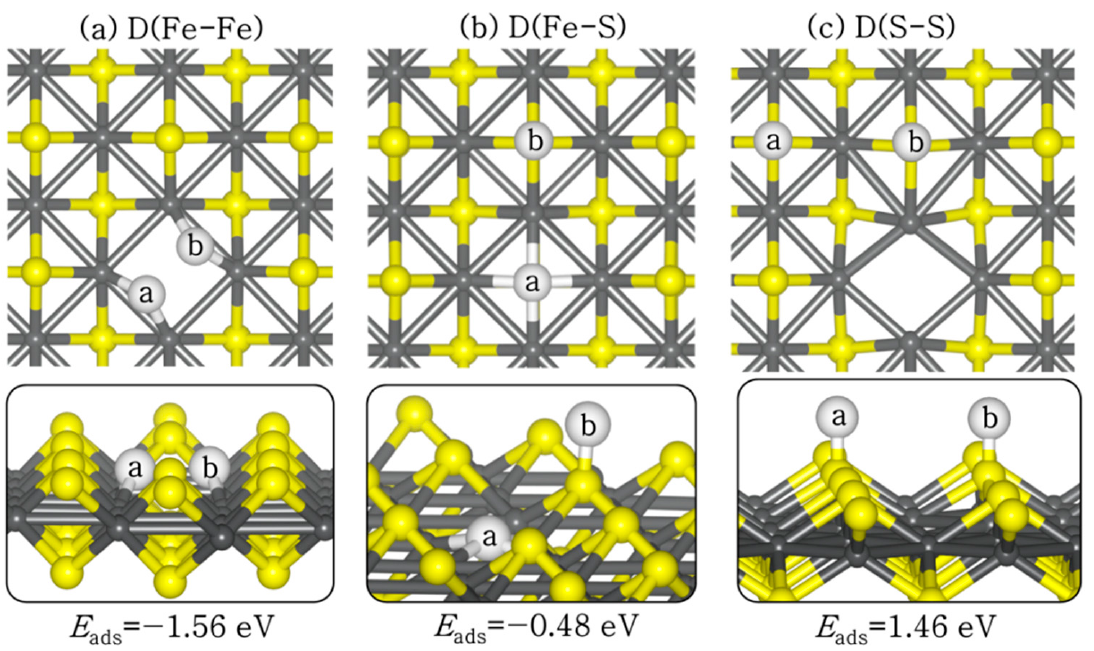
Figure 6. Lowest-energy adsorption structures of dissociated (D) H 2 on defective V S1 FeS (001) surface at ( a ) Fe–Fe, ( b ) Fe–S, and ( c ) S–S sites, in top ( top ) and side ( down ) views. (Atomic colour code: Fe = grey, S = yellow, H = white.) Table 2. Adsorption energies and structure of H 2 on perfect and defective FeS(001), where M and D denotes molecular and dissociative adsorption modes, respectively. Configuration